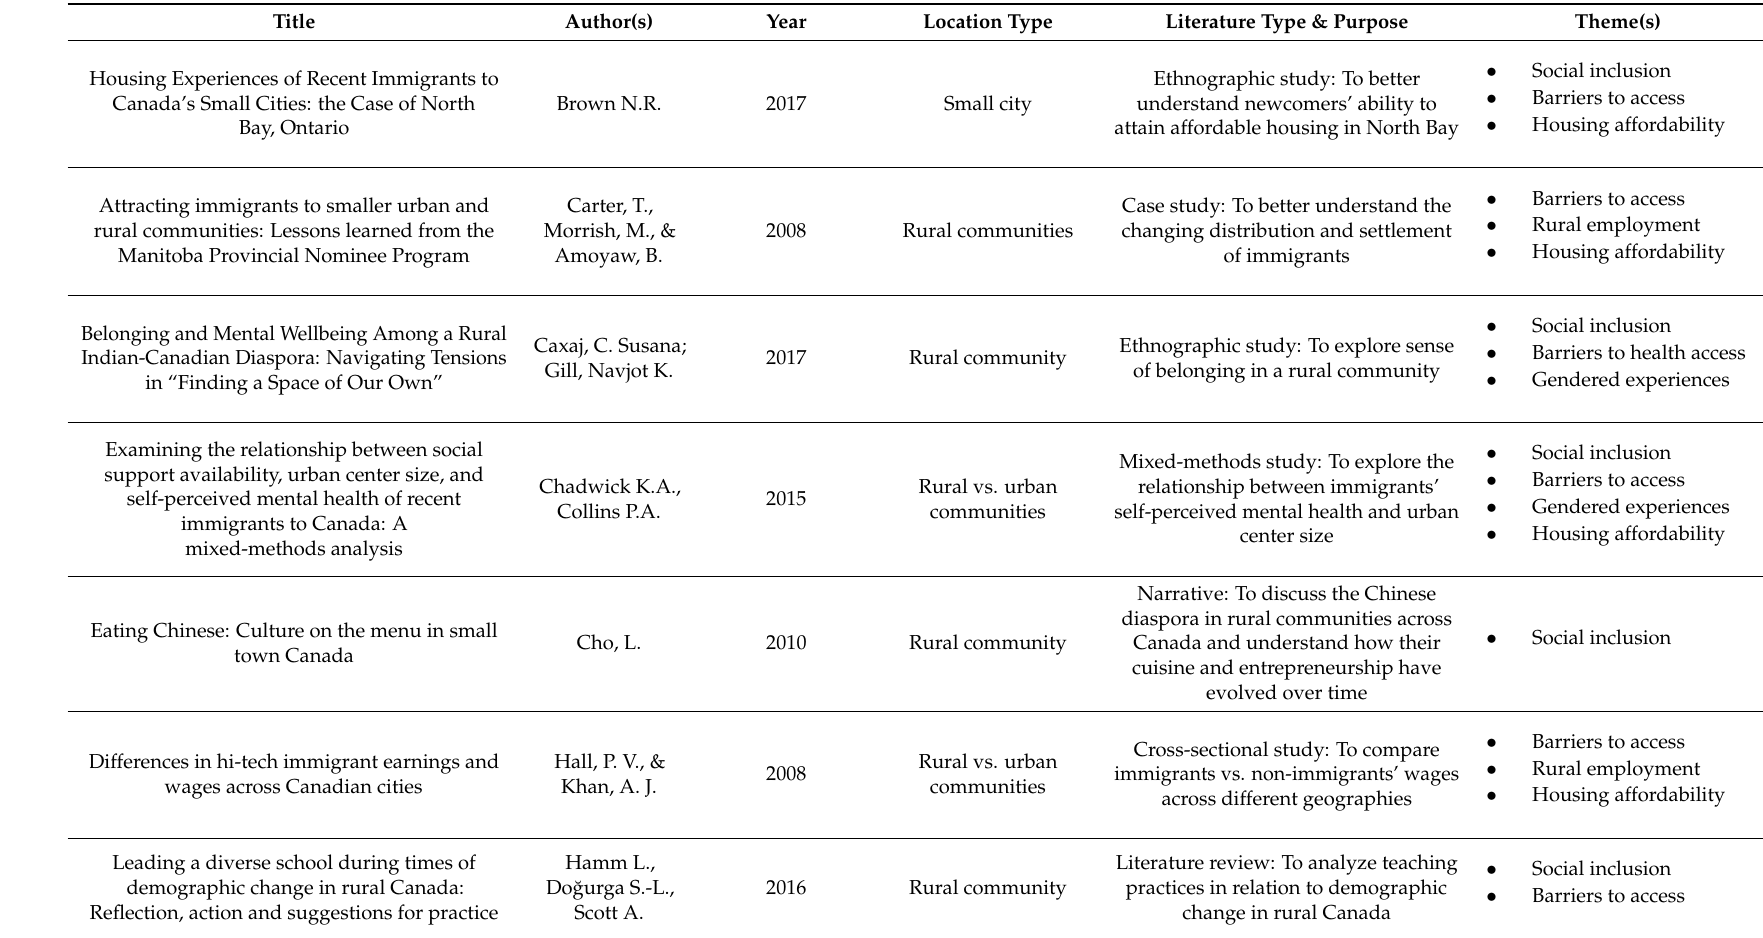
Table A1. Summary of included